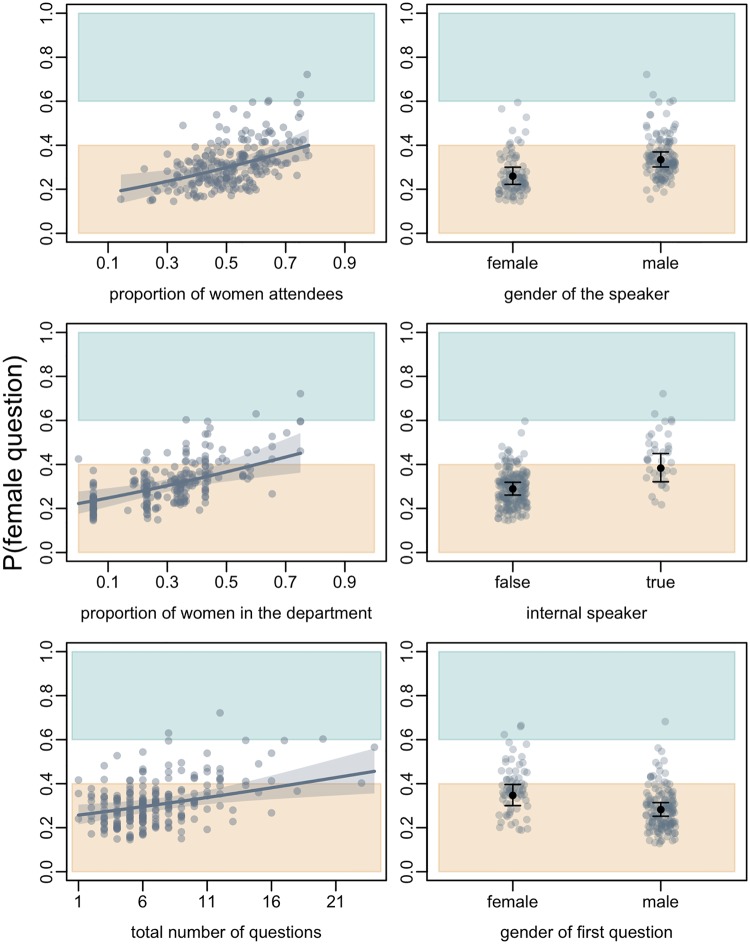
The effects predicting the probability of question asked by a female audience member after departmental seminars.Plotted are the effects of (a) the proportion of attendees who were women; (b) the proportion of faculty in the department who are women; (c) the total number of questions that were asked; (d) the gender of the speaker; (e) whether the speaker was internal to the department (true) or not (false); and (f) the gender of the first person to ask a question on the proportion of questions asked by women after a departmental seminar. In each panel, the coloured boxes reflect the areas of disparity in the proportion of questions asked by women after a seminar, with the white area representing moderate to no disparity (proportion of questions from women = 0.50 ± 0.10), the orange area representing a disparity towards male audience members asking questions (proportion of questions from women <0.4) and the green area representing a disparity towards female audience members asking questions (proportion of questions from women >0.6). The predicted values are plotted in all cases to control for other effects. In panels (a)-(c), the predicted logistic relationship is plotted in grey with a transparent grey polygon indicating the standard error around the relationship. Likewise, in panels (d)-(f), the predicted values of the effects are plotted as black points with standard error bars.